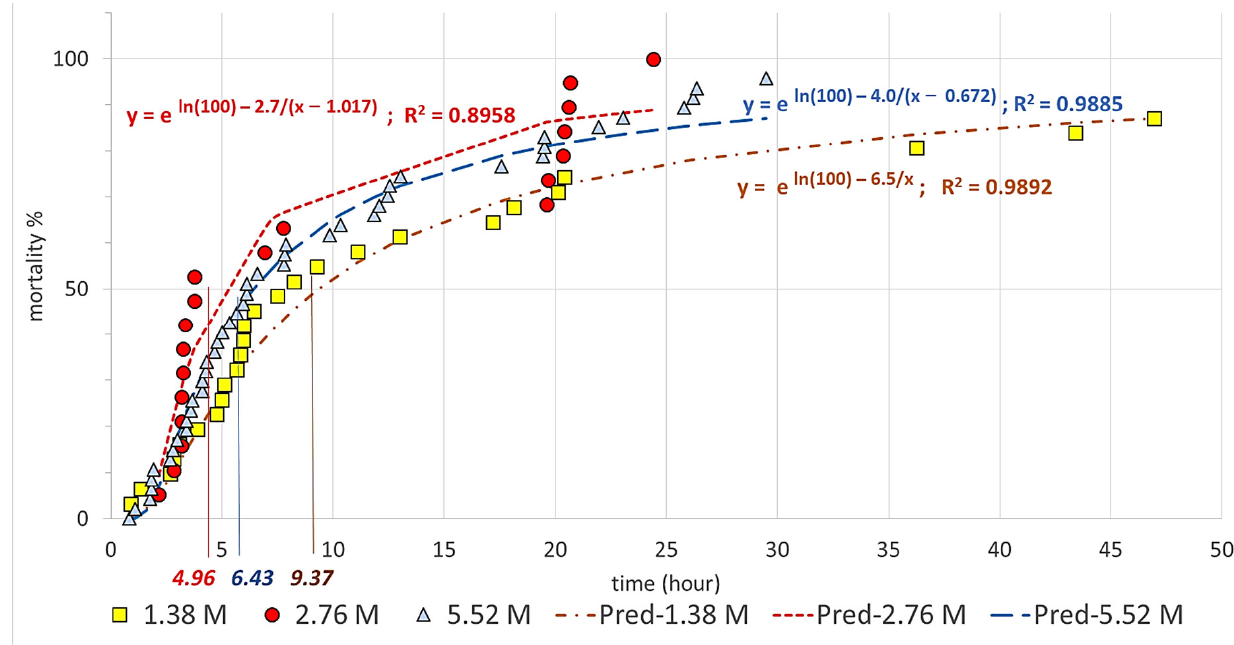
Figure 2. Abbott-corrected mortality rates for the three lithium chloride